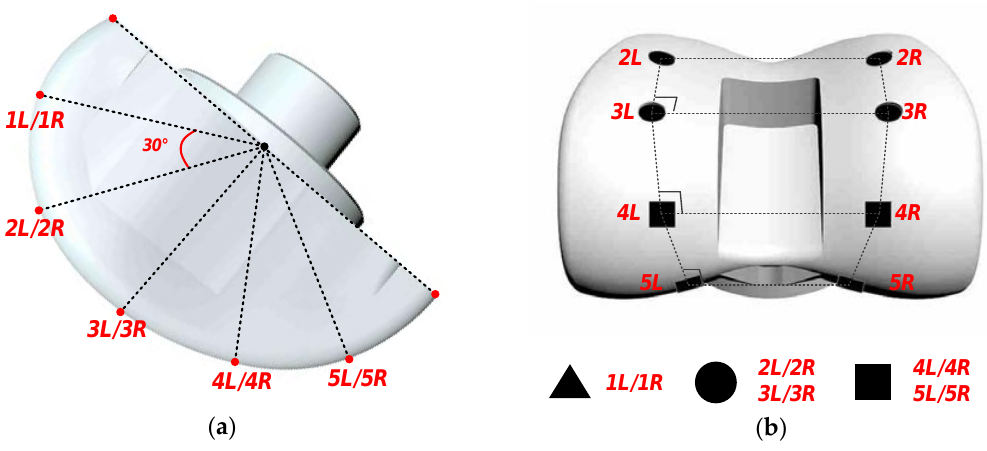
Figure 9. Femoral component with five pairs of control points on its surface: ( a ) side view, ( b ) front view (partial).